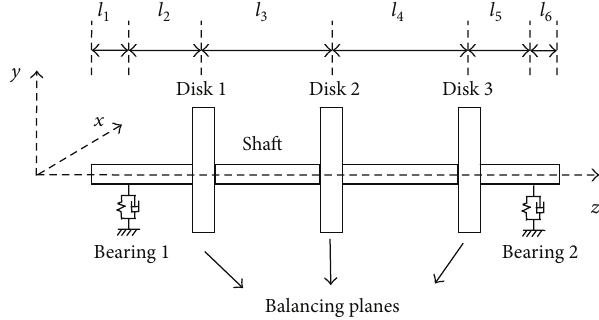
Figure 3: Universal rotor-bearing rotor